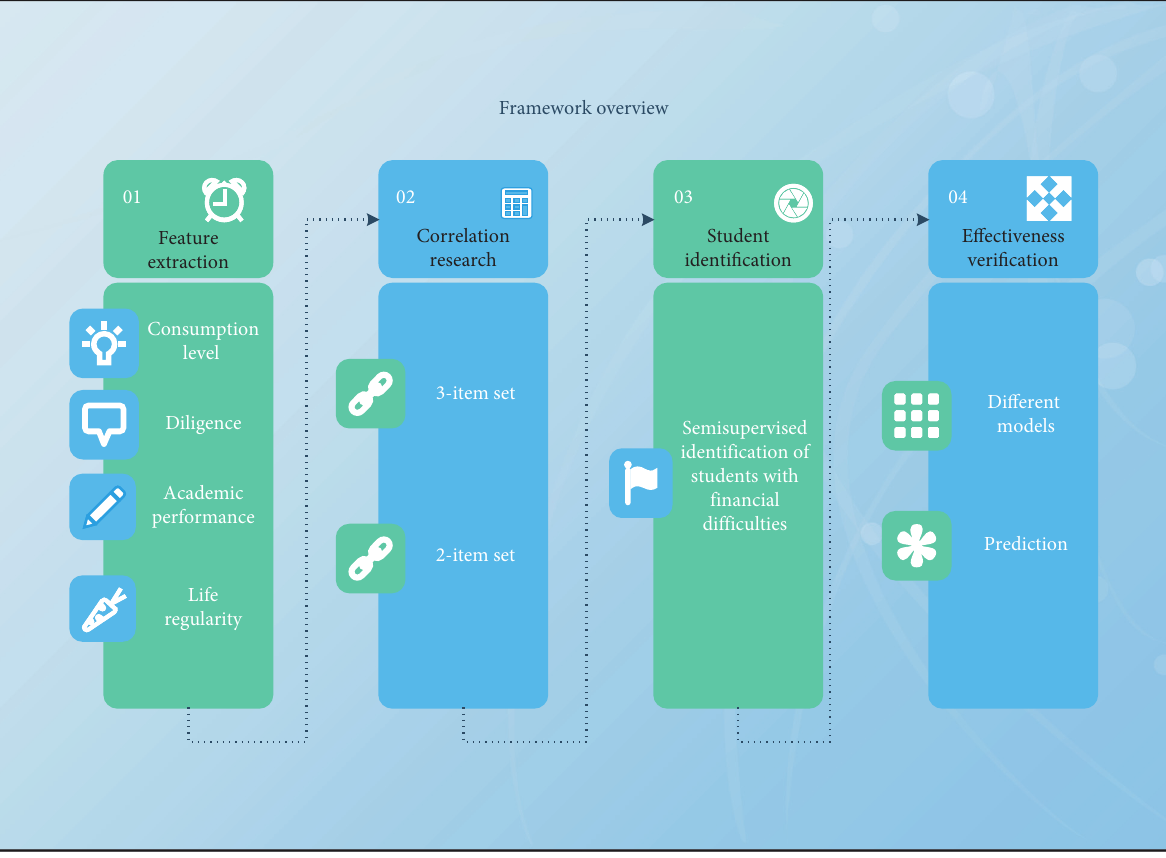
Figure 1: Framework overview.